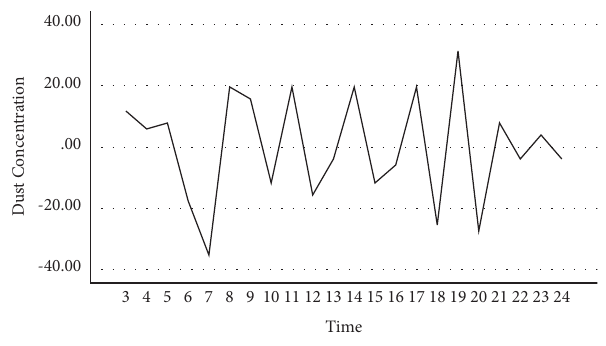
Figure 3: Sequence diagram after